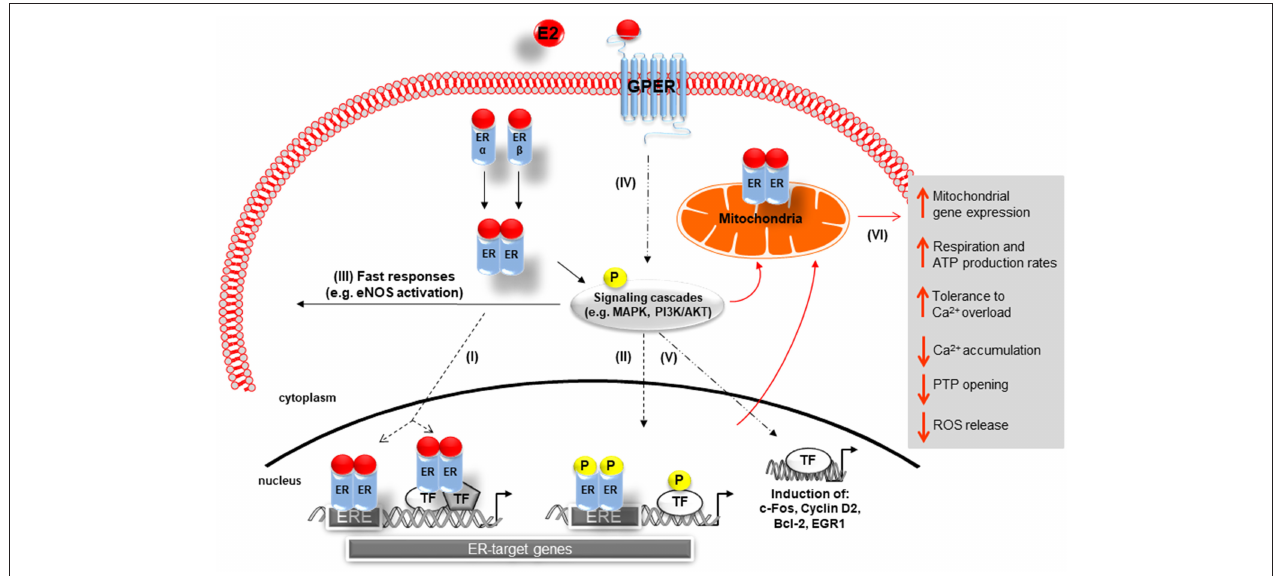
FIGURE 1 | Schematic representation of 17 β -Estradiol induced estrogen receptor-alpha, -beta, and G-protein-coupled estrogen receptor signaling. Genomic pathway: (I) The E2/ER complex can bind to estrogen response elements (ERE) within the promoter of target genes or regulates gene transcription by interacting with other transcription factors (TF), e.g., AP-1 and Sp1. (II) In addition, E2/ER activate signaling transduction pathways, leading to phosphorylation of ER or other bound transcription factors modulating gene expression. In the non-genomic action: (III) E2-activated ER lead to rapid tissue responses via phosphorylation of cytosolic signaling cascades. (IV) GPER predominantly mediates rapid, non-genomic E2 signaling by the involvement of several kinases, ion channels, and second messengers. (V) GPER is also involved in gene expression regulation. (VI) E2 initiated cellular and mitochondrial ER/GPER genomic and non-genomic actions modulate mitochondrial respiration, ATP production, and ROS formation (indicated by red arrows). E2, 17 β -estradiol; ER, estrogen receptor alpha and beta ERE, estrogen response element; TF, transcription factor; P, phosphorylation; GPER, G-protein-coupled estrogen receptor; Ca 2 + , calcium, PTP, permeability transition pore; MAPK, mitogen-activated protein kinases; PI3K/AKT, phosphoinositide 3-kinase-serin/threonine-specific kinase B; eNOS: endothelial nitric oxide